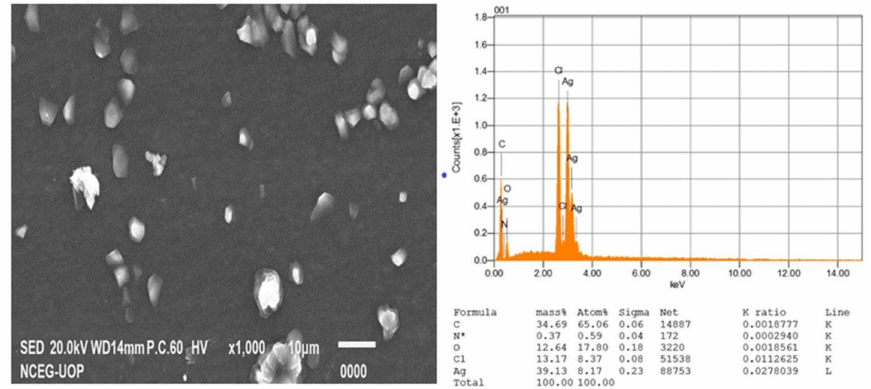
Figure 5. ( a ) SEM images and ( b ) EDX spectra of AgNPs prepared from L. lucidum .